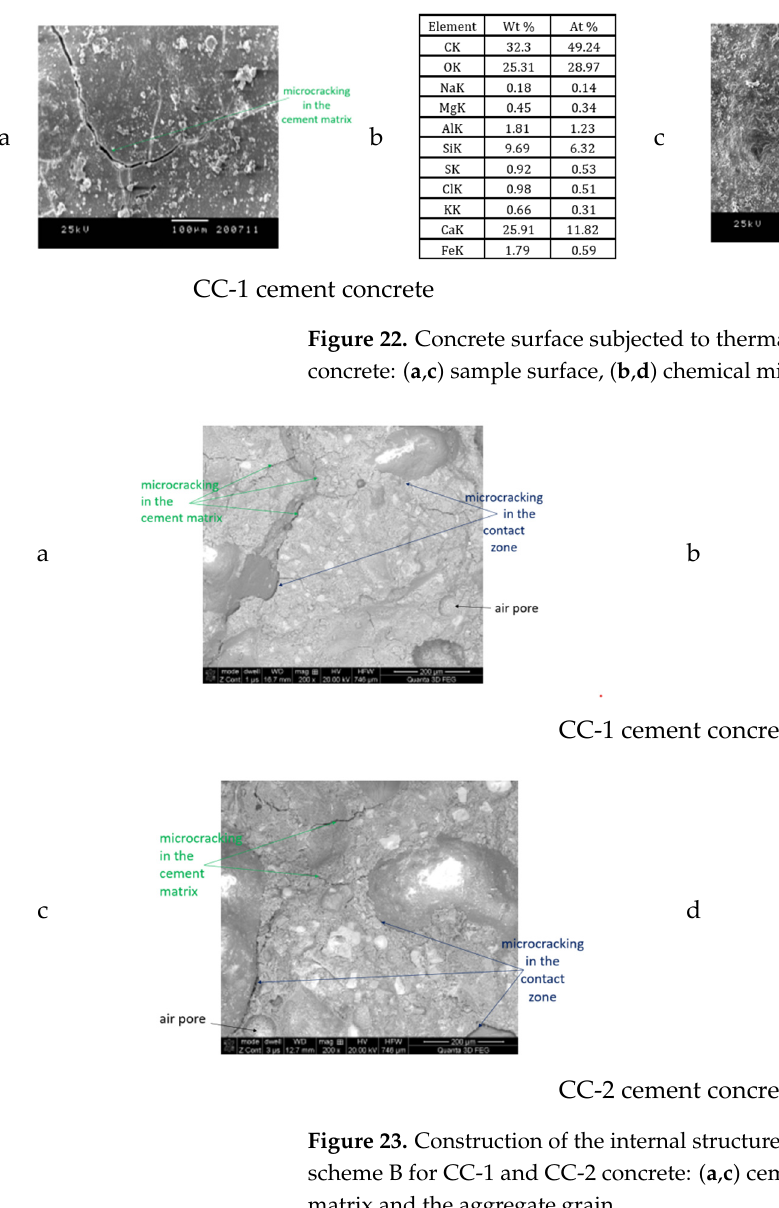
Figure 21. Construction of the internal structure of concrete subjected to thermal cycles according to scheme A for CC-1 and CC-2 concrete: ( a , c ) contact zone between the cement matrix and the aggregate grain, ( b , d ) cement matrix.